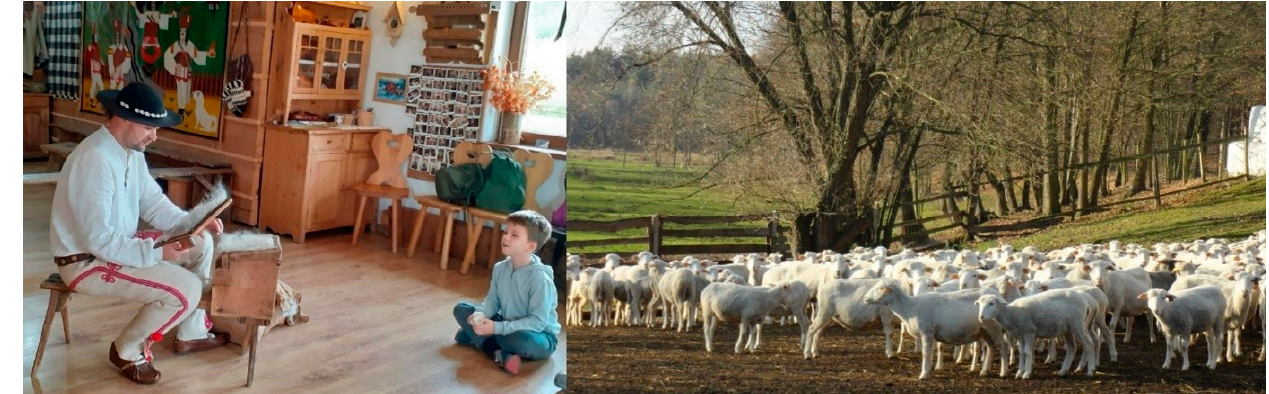
Figure 6. Education and agritourism farms breeding sheep of native breeds (https://ksp-zakopane.pl, accessed on 1 March 2022).